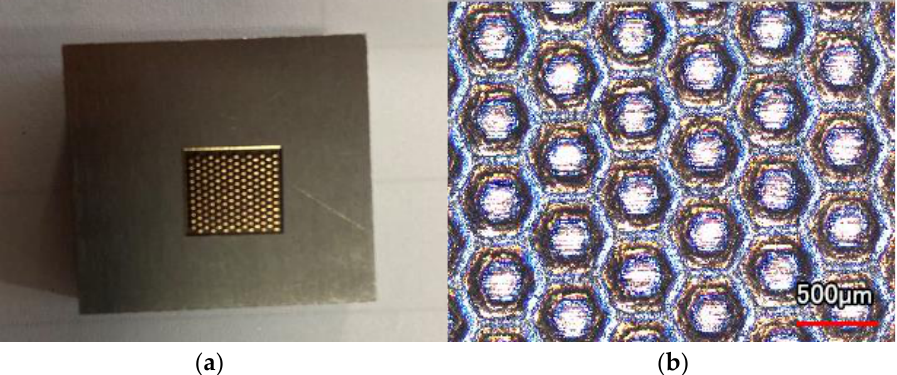
Figure 12. Array of regular hexagonal tabs. ( a ) Physical picture, ( b ) Surface morphology diagram.